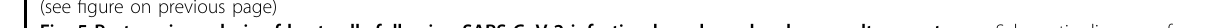
Fig. 5 Proteomic analysis of host cells following SARS-CoV-2 infection based on alveolar co-culture system. a Schematic diagram of experimental fl ow for quantitative proteomic analysis based on the alveolar co-culture system. For each treatment, three biological replicates were prepared. b Heatmap showed proteomic changes of cells following SARS-CoV-2 infection. c Volcano plots showed the regulated proteins of cells following SARS-CoV-2 infection. Proteins differentially expressed with fold change over 1.5 and p < 0.05 were marked in color. P -values were calculated using a two-sided, unpaired Student ’ s t test with equal variance assumed ( n = 3 independent biological samples). d Venn diagrams showed the differentially expressed proteins shared or unique between each comparison. e Gene Ontology enrichment analysis of DEPs in HPAEpiC cells following SARS-CoV-2 infection based on biological process. f Gene Ontology enrichment analysis of DEPs in HULEC-5a cells following SARS- CoV-2 infection based on biological process. e , f The vertical axis shows the top 20 enriched biological processes, and the horizontal axis represents rich factor. The color and size of the dots represent the range of the P -value and the number of DEGs mapped to the indicated GO terms, respectively. A two-tailed Fisher ’ s exact test was employed to test the enrichment of the differentially expressed protein against all identi fi ed proteins. The GO with a corrected p -value < 0.05 is considered signi fi